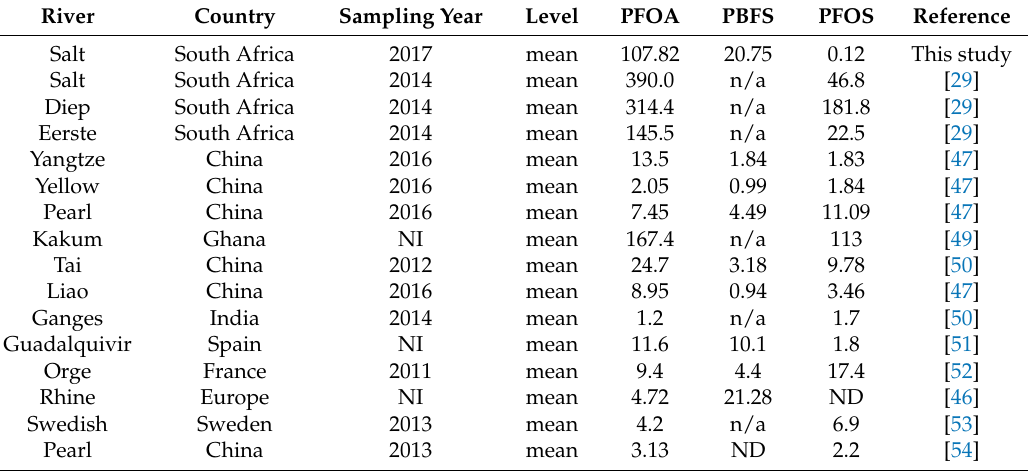
Table 5. Comparison of PFOA, PFOS and PFBS levels (ng/L) in rivers from previous studies.